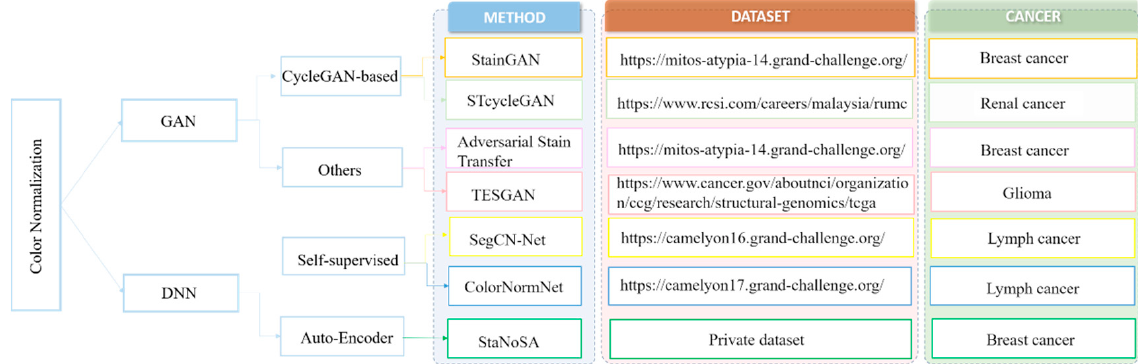
Figure 3. Overview of papers using deep learning for color normalization in histopathological images [35–41].